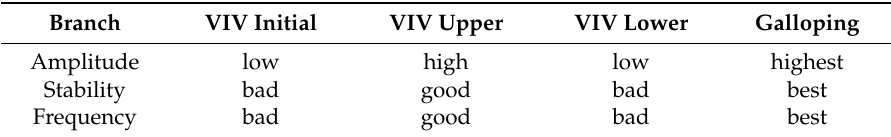
Table 5. Oscillation characteristics of different